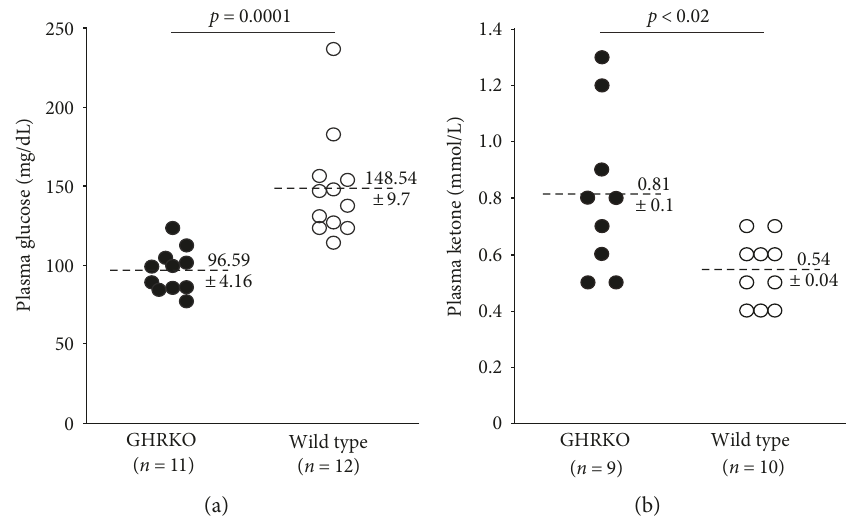
Figure 1: Fasting plasma glucose and ketone levels in GHRKO mice and controls. (a) GHRKO mice exhibited signi fi cantly lower plasma glucose levels compared to controls following a 5-hour fast. (b) GHRKO mice exhibited signi fi cantly greater plasma ketone levels compared to controls following a 5-hour